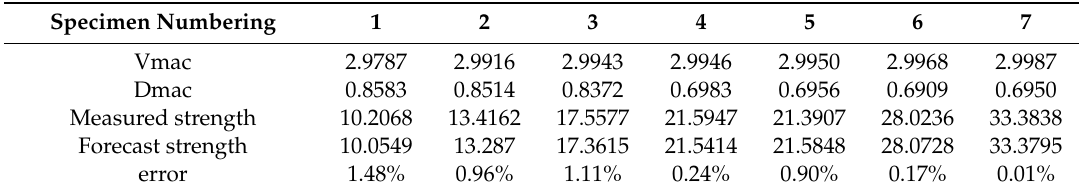
Table 11. Statistics of the strength prediction results of non-test group sandstone specimens.